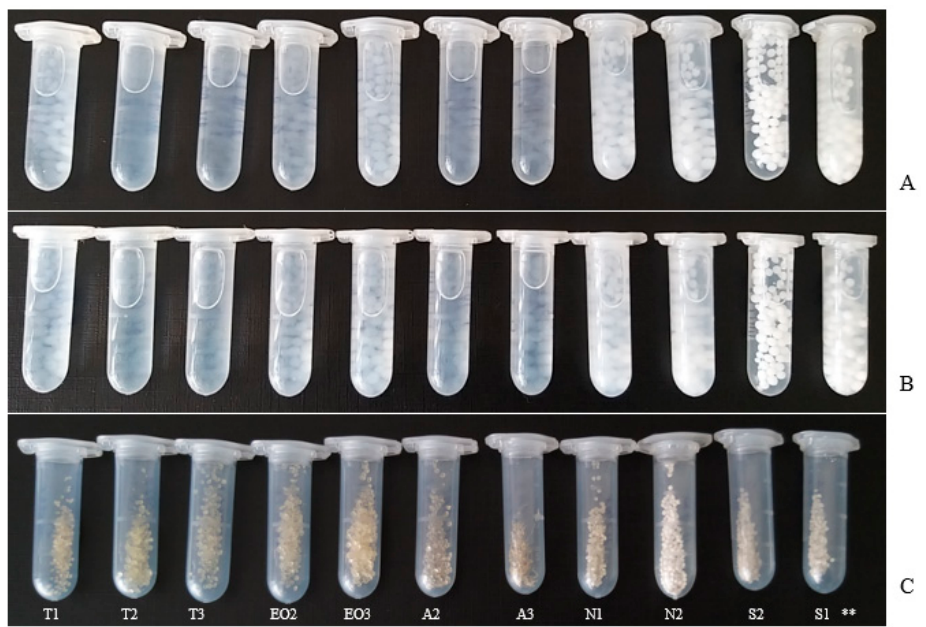
Figure 5. NEO-loaded microcapsules. Wet capsules in the crosslinker solution: ( A ) 2% solution; ( B ) 5%; ( C ) dry microcapsules (2% crosslinker solution). ** The code of microcapsules is given in Table 1.